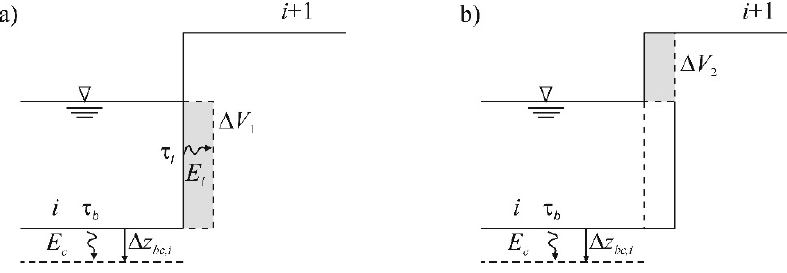
Figure 1. Sketch of the lateral erosion process: ( a ) bank undercutting causes the removal of a volume Δ V 1 , and ( b ) mass instability causes the failure of a volume